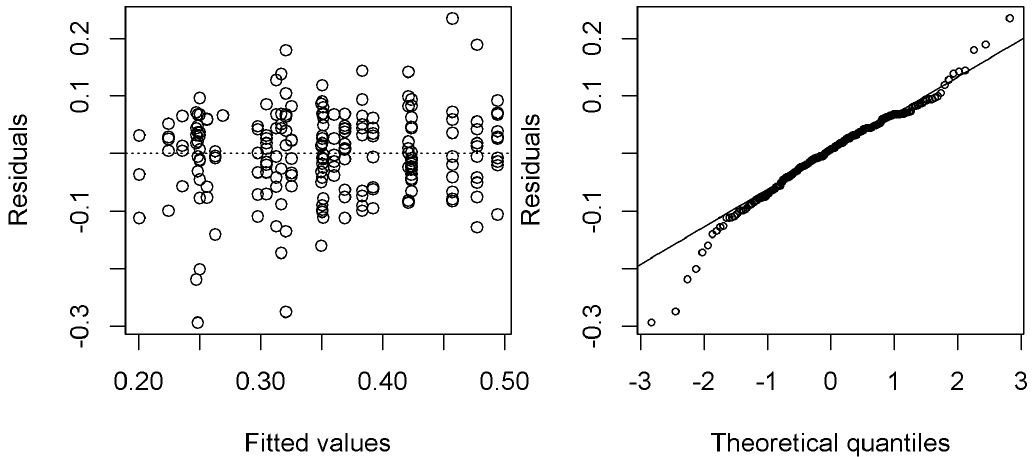
Figure A2. Residuals of the linear model used to model seedlings relative growth rate in height. The analysis of models’ residuals showed that conditions for normality, homoscedasticity, and independency between observations were correctly met. All